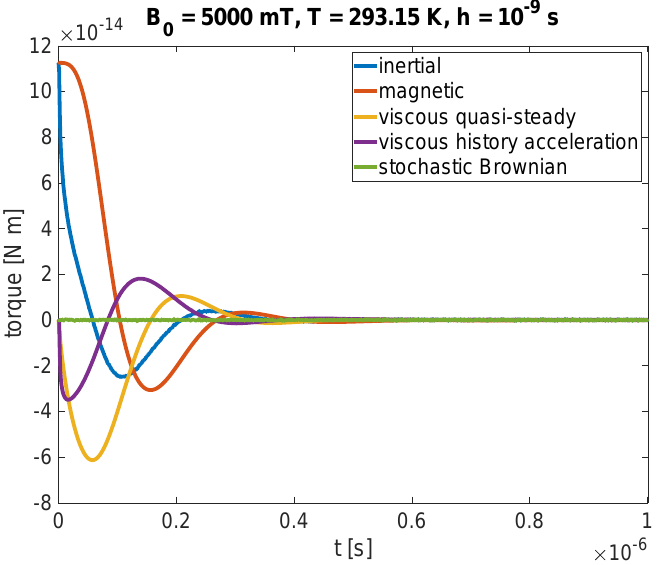
Figure 2. Time evolution of each kind of torque for the strong B 0 field limit generated with the SIDE model. For comparison, see the time evolution of ϕ ( t ) and ω ( t ) in Figure